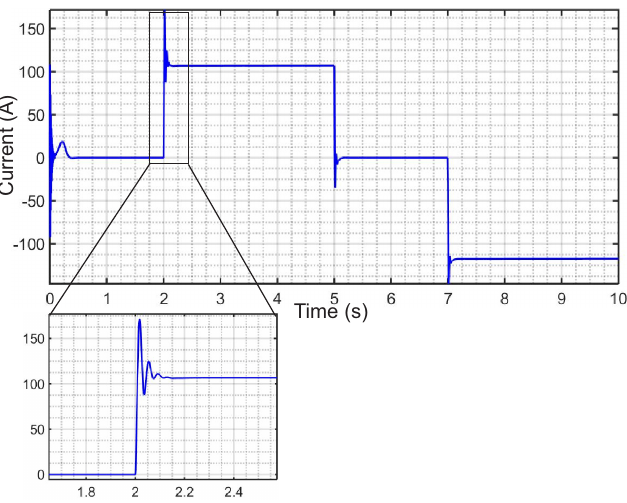
Figure 13. Source current during charging and